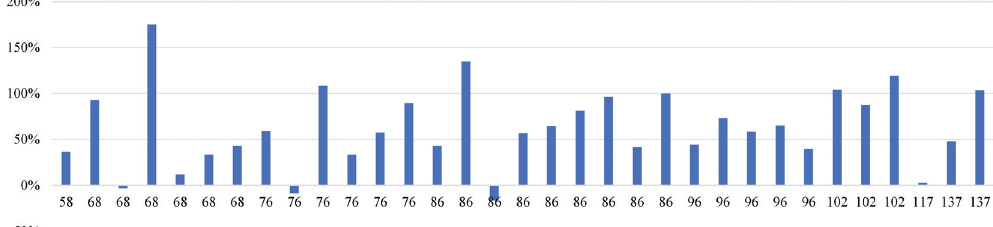
Figure 19. Light difference between Dialux and measured values by LED luminary